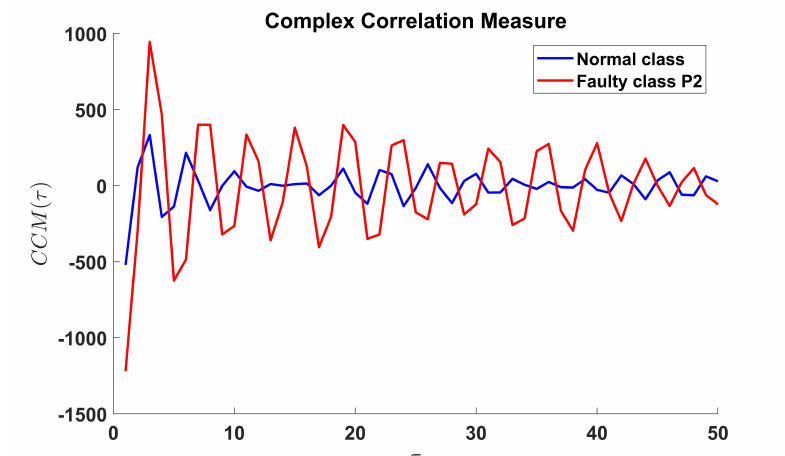
Figure 17. CCM for a vibration signal of the healthy class (blue) and for the faulty class P2 (red). The calculation considers a variation of τ between 1 and